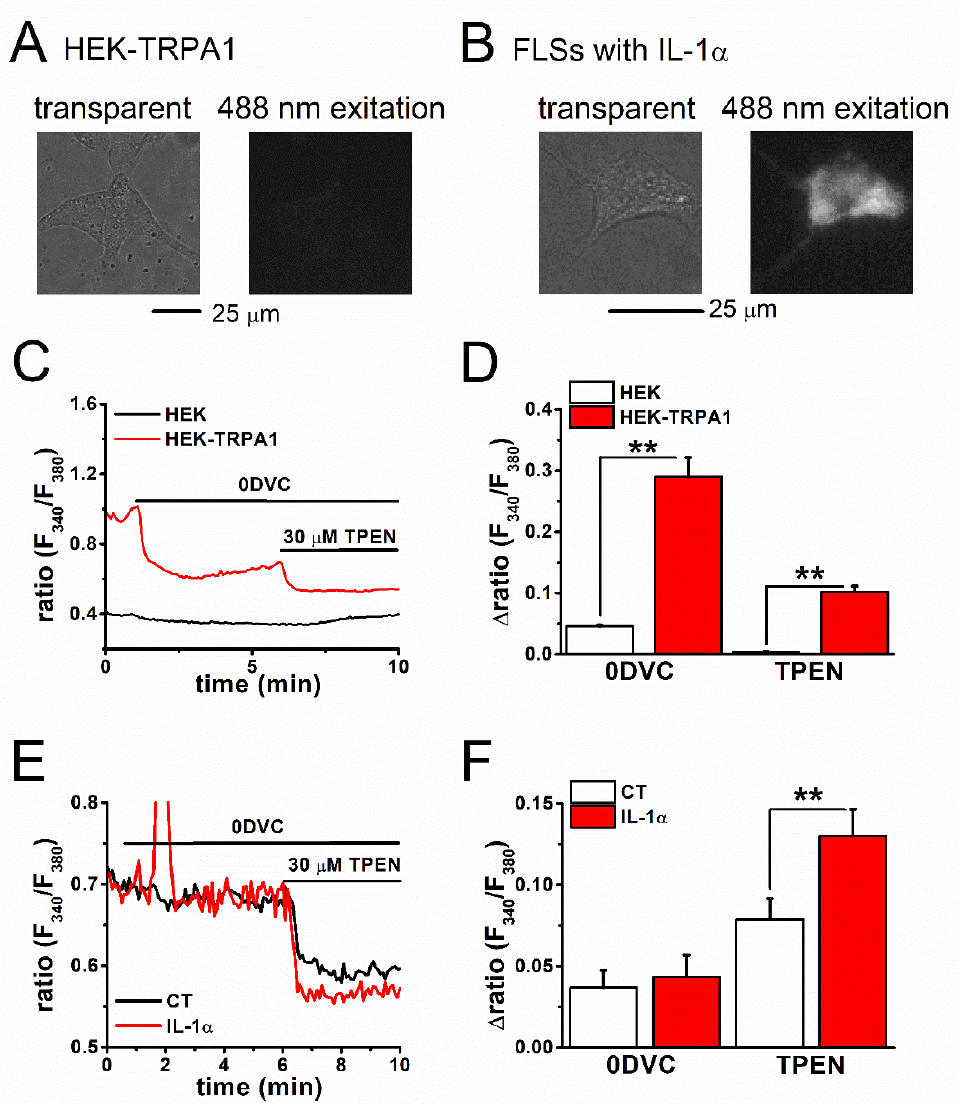
Figure 3. The assay of [Zn 2+ ] i in TRPA1-expressing cells using a Fura-2 based assay. Auto-fluorescence images of ( A ) HEK-TRPA1 cells and ( B ) FLSs with IL-1 α in the absence of fluorescence indicators. Fluorescence images acquired in cells excited with light of 488 nm wavelength (right panels) and light-transmitting images (left panels) are shown. Comparison of TPEN-sensitive [Zn 2+ ] i components that were assayed with Fura-2 between ( C , D ) HEK cells with and without expression of TRPA1 or ( E , F ) FLSs with and without IL-1 α . Cells were treated with 30 µ M TPEN in the presence of 0DVC without EGTA. The fluorescence signal measured as a ratio (F 340 /F 380 ) and the corresponding peak change in the presence of ( D ) 0DVC and ( F ) TPEN are plotted (mean ± SEM; n = 101 and n = 111 for HEK and HEK-TRPA1, respectively, and four independent experiments each; n = 33 and n = 31 for CT and 100 U IL-1 α , respectively, and four independent experiments each; ** p < 0.01).